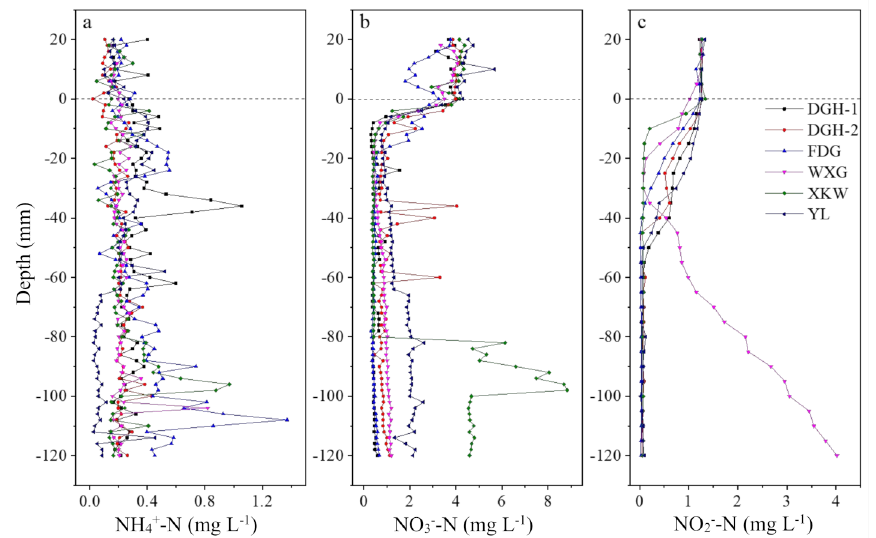
Figure 3. Vertical distribution of dissolved inorganic nitrogen (DIN) concentration in sediment profiles of sampling sites. NH 4+ -N ( a ) and NO 3 − -N ( b ) concentration were measured by AMP-TH DGT with 2 mm intervals and NO 2 − -N ( c ) concentrations were measured by HR-Peeper with 5 mm intervals. Dashed lines indicated approximated positions of sediment–water interface